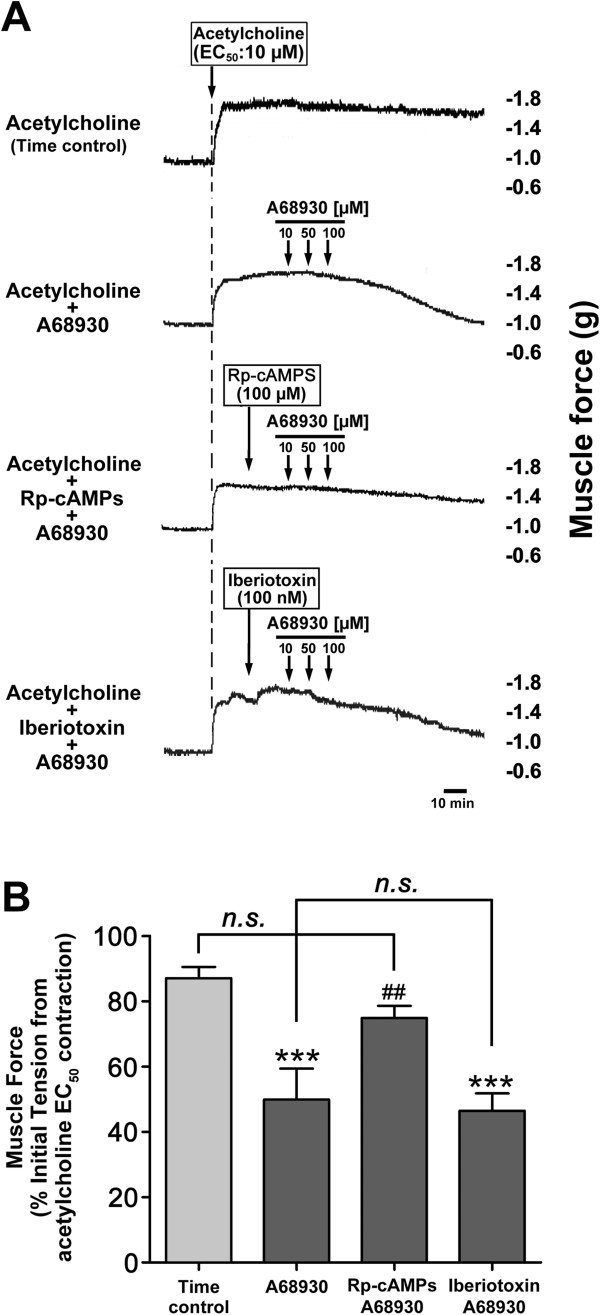
PKA is involved in dopamine D1 receptor agonist-induced airway smooth muscle relaxation. (A) Representative tension tracing in guinea pig tracheal ring illustrating the effect of pretreatment with the PKA inhibitor Rp-cAMPS (100 μM) or BKCa channel blocker iberiotoxin (100 nM) on relaxation of Ach (EC50) contraction by the dopamine D1-like receptor agonist A68930 (10 - 100 μM). (B) The effect of pretreatment with the PKA inhibitor Rp-cAMPS (100 μM) or BKCa channel blocker iberiotoxin (100 nM) on A68930 (100 μM)-mediated tracheal ring relaxation. Means ± SEM. ***P < 0.001 compared with time control. ##P < 0.01 compared with A68930 alone. N = 6.